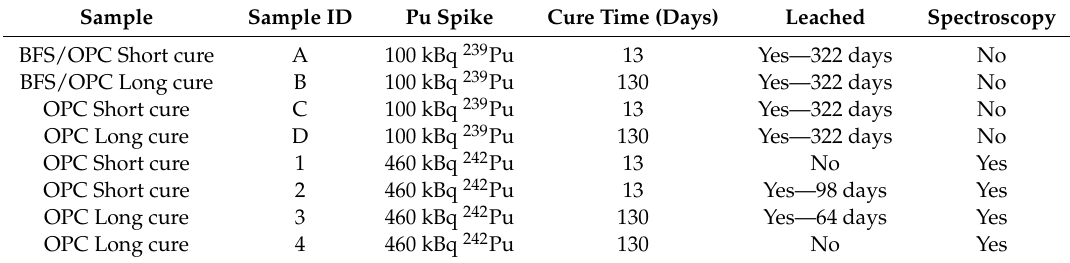
Table 1. Summary of Pu-containing sample preparation and pre-treatment. Samples containing 239 Pu were used for leaching experiments, while those containing 242 Pu were used for spectroscopic studies. Leached and unleached examples of the 242 Pu-containing samples were